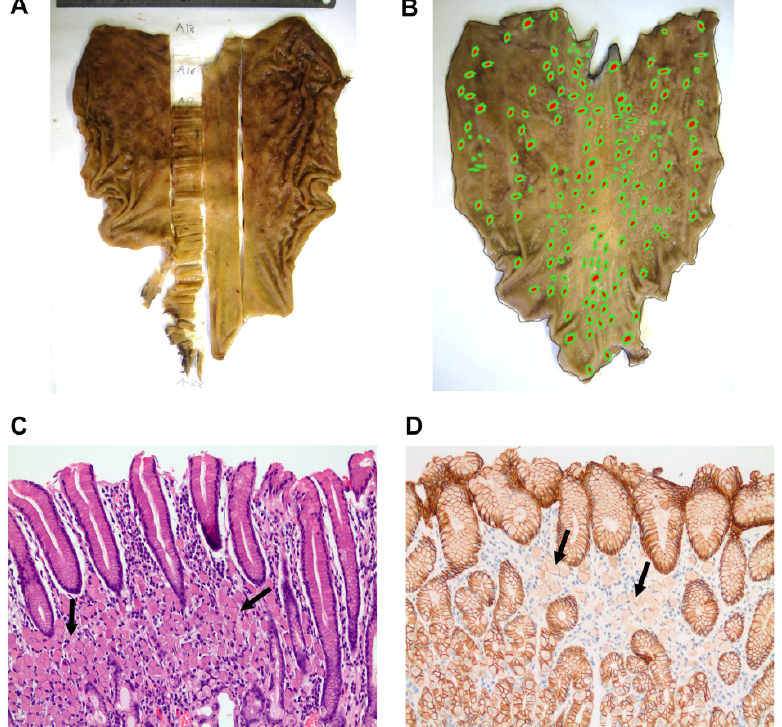
Figure 2. Macroscopic and microscopic features of gastrectomy specimens. ( A ) Procedure used to include entire stomachs for systematic histological analysis. ( B ) Gastrectomy specimen from Subject IV-51. Dots indicate the sites where microscopic lesions were identified. ( C ) Representative image of a focus of signed ring cell carcinoma restricted to the upper half of the mucosa (Subject IV-52, hematoxilin-eosin staining, × 200 magnification, arrows). ( D ) Immunohistochemistry showing intact membrane expression of E-cadherin in the non-tumoral foveolar epithelium and focal loss of staining in tumor cells from Subject IV-52 (×200 magnification, arrows).